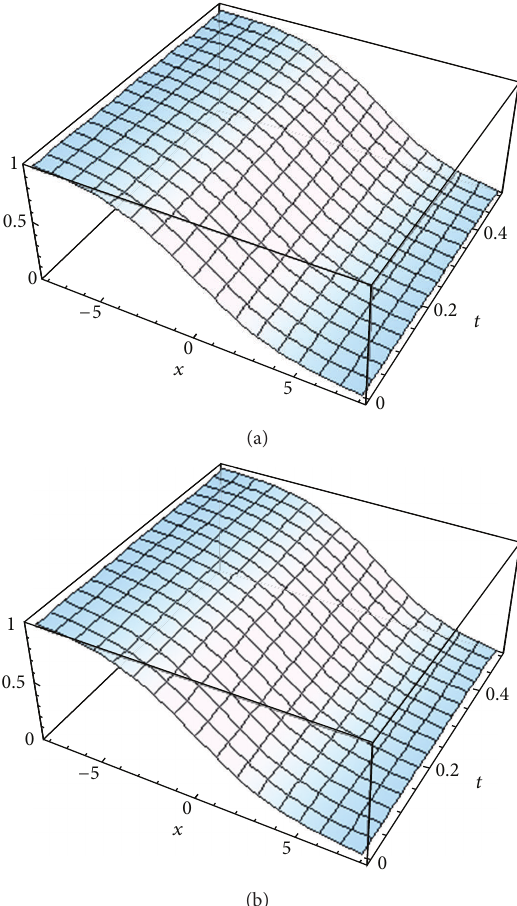
(𝑥,𝑡) are shown, respectively, from (b) to Figure 1: 𝑢(𝑥, 𝑡) and 𝑢 app (a), when −5 ≤ 𝑥 ≤ 5 and 0 ≤ 𝑡 ≤ 0.5 , for Fisher equation, with 𝑛 = 11 , 𝛼 = 1